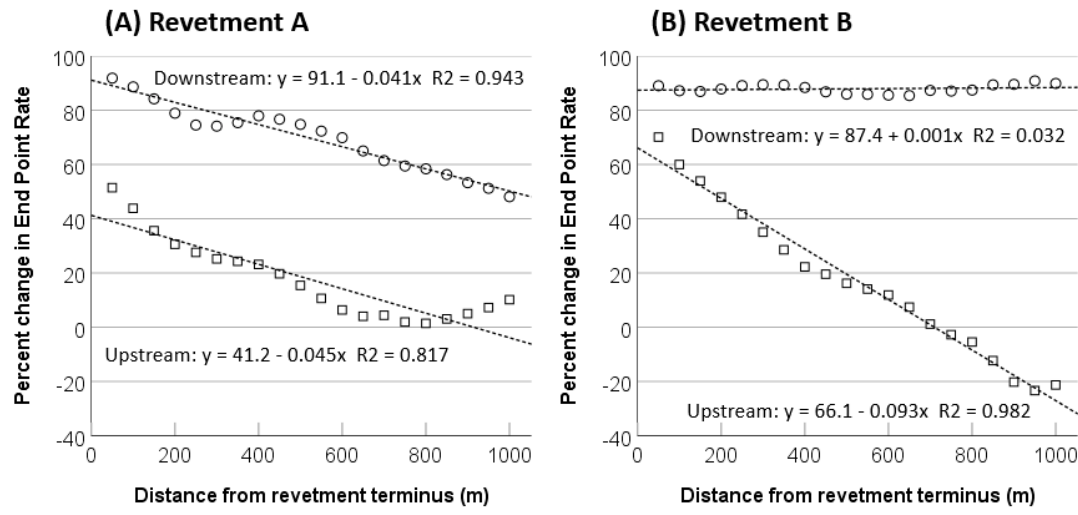
Figure 8. Percent change in End Point Rate: ( a ) Revetment A, ( b ) Revetment B; squares = upstream, circles = downstream; linear regression trend lines shown.